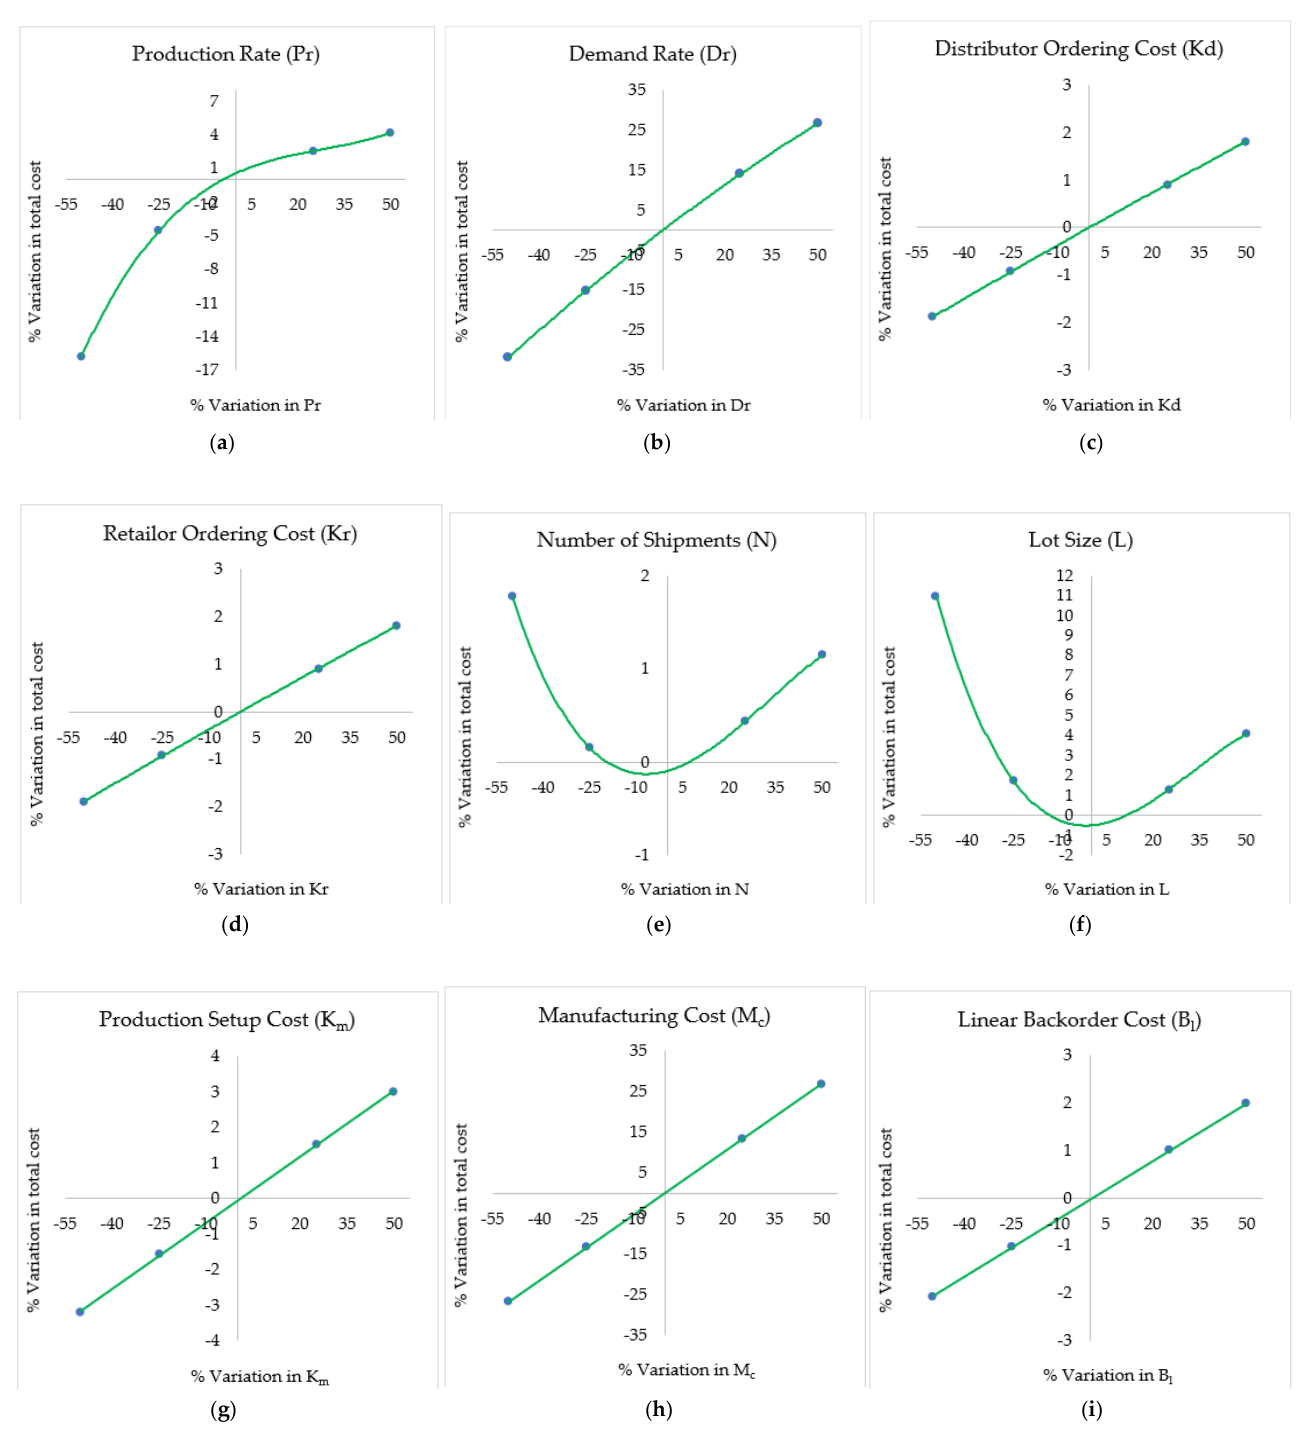
Figure 4. ( a – i from top left to bottom right). Sensitivity analyses of important parameters (Case 2).